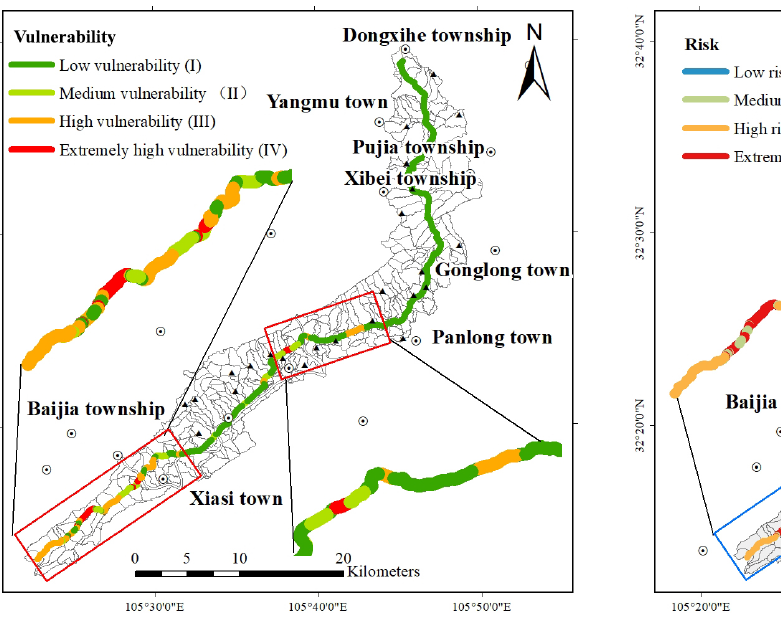
Figure 6. Pipeline vulnerability map of study area. Figure 7. Pipeline risk map of study